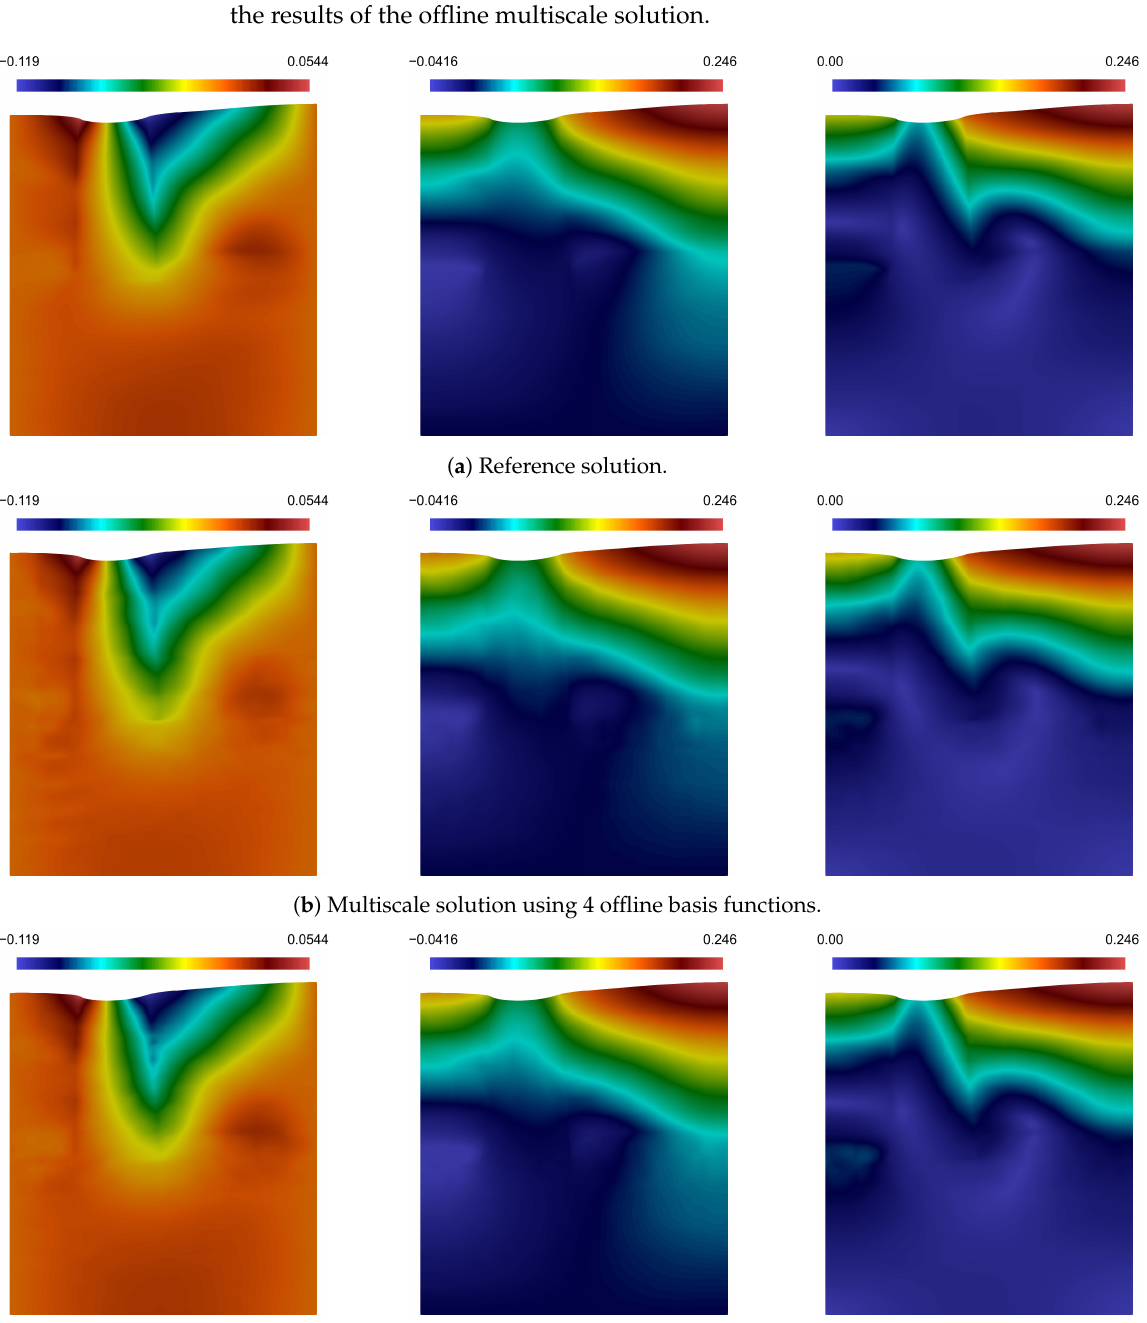
Figure 10. Distributions of u 1 , u 2 , and | u | (from left to right) at the final